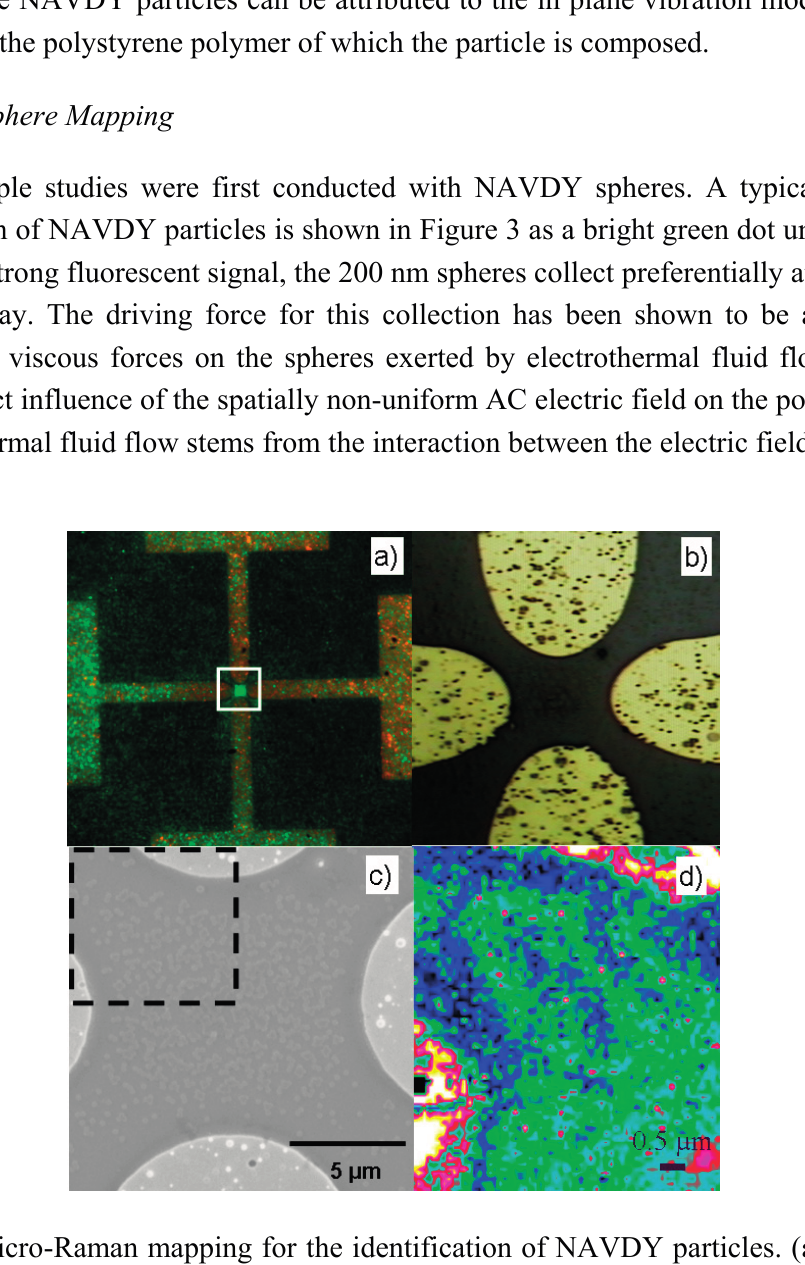
Figure 3. Micro-Raman mapping for the identification of NAVDY particles. ( a ) UV-light image of NAVDY particles captured in the center of microelectrodes; ( b ) Magnified view of the area outlined with a white box in (a) as appears under visible light; ( c ) SEM image of NAVDY particles captured on an anti-avidin functionalized surface; ( d ) Micro-Raman mapping of a portion of the SEM image as indicated by the dashed